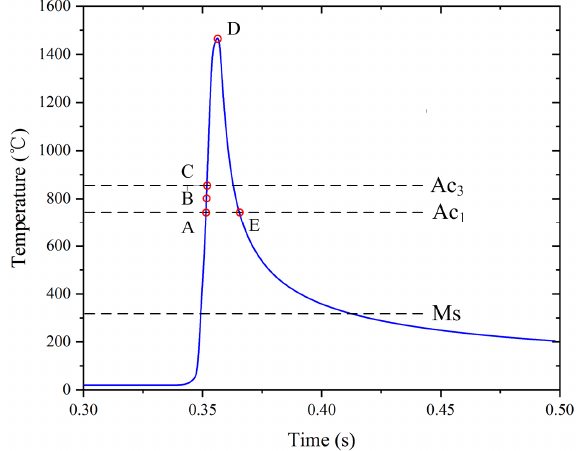
Figure 4. Temperature history with grinding time.